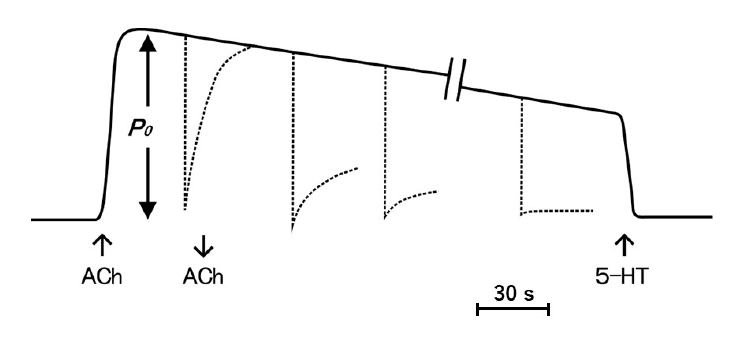
Figure 1. Schematic diagrams showing mechanical responses of the ABRM during the active tension development ( a , c ) and during the catch state ( b , d ). Upper traces represent changes in fiber length, while lower traces represent changes in tension. The ABRM is first stimulated by ACh (0.1 mM), and after the maximum isometric tension (Po) is developed, it is subjected to a reduction in load from Po to P < Po ( a ), or subjected to a quick release (magnitude, 5% of slack length, Lo) ( c ). When the ABRM is put into the catch state after removal of ACh, it no longer shortens after a reduction of load ( b ), and no longer redevelops tension after a quick release ( d ).